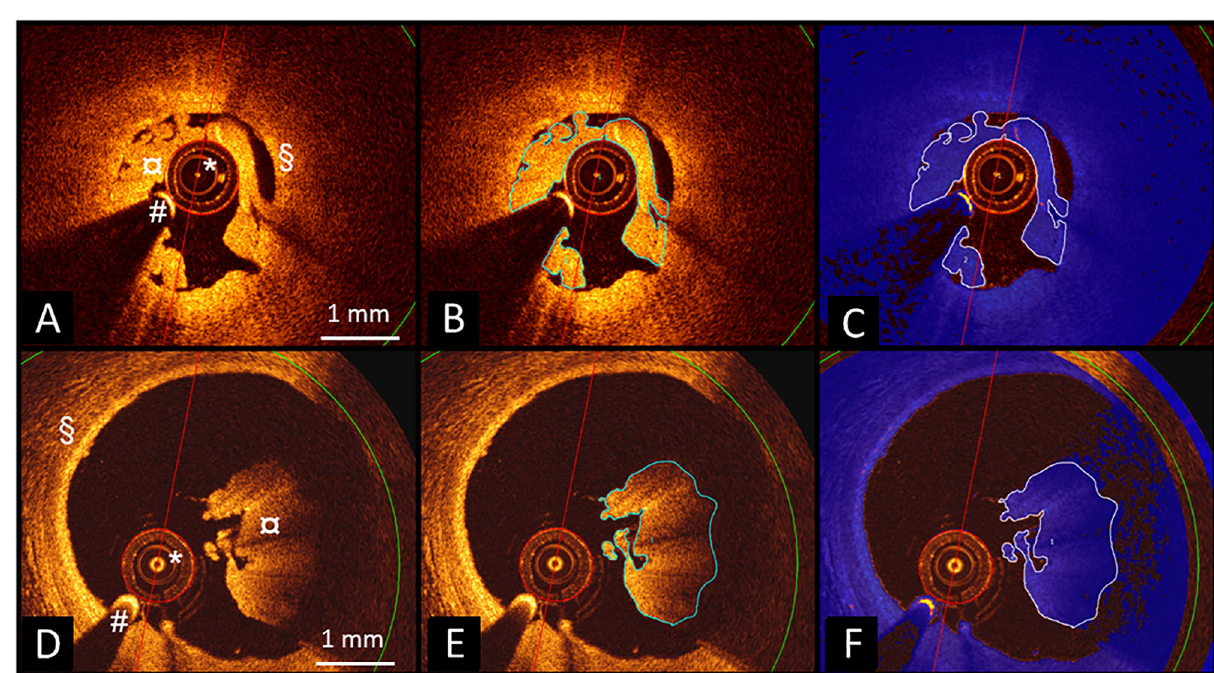
Fig 1. Examples of thrombus assessment by the QCU-CMS image analysis software in OCT image frames of two patients with white (A) and red thrombus (D). After manual tracing of the thrombi (B,E), attenuation analysis was performed including regions with attenuation values above the designated threshold value (displayed in blue) (C,F). Accurate segmentation of the luminal border of the thrombus and the contrast-filled flow area of the vessel can be seen in C and F. � ) OCT catheter, #) guidewire artefact, ¤) thrombus, §) vessel wall. OCT, optical coherence tomography.